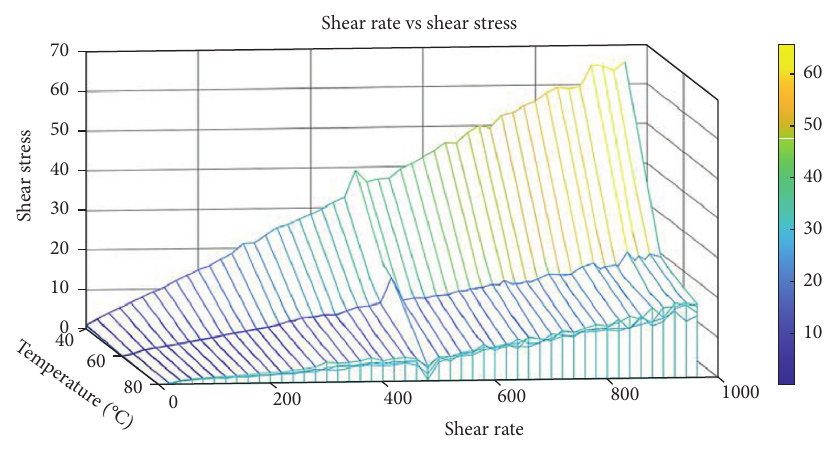
Figure 19: Plot of shear stress to shear rate. Table 6: Correlation and regression analyses between shear stress and shear rate. Sample